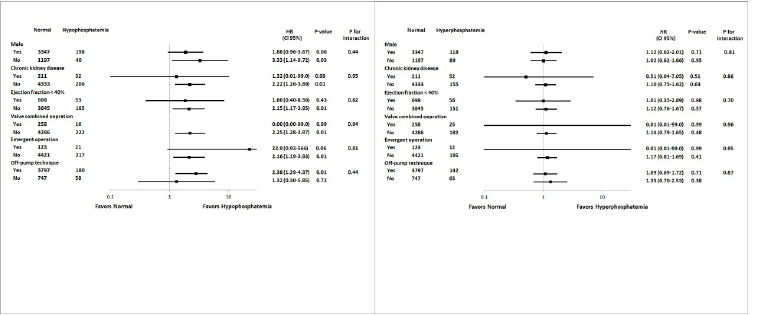
Fig 2. Subgroup analysis of graft failure according to the following variables: male sex, chronic kidney disease, ejection fraction < 40%, valve combined operation, emergent operation, and the off-pump technique.